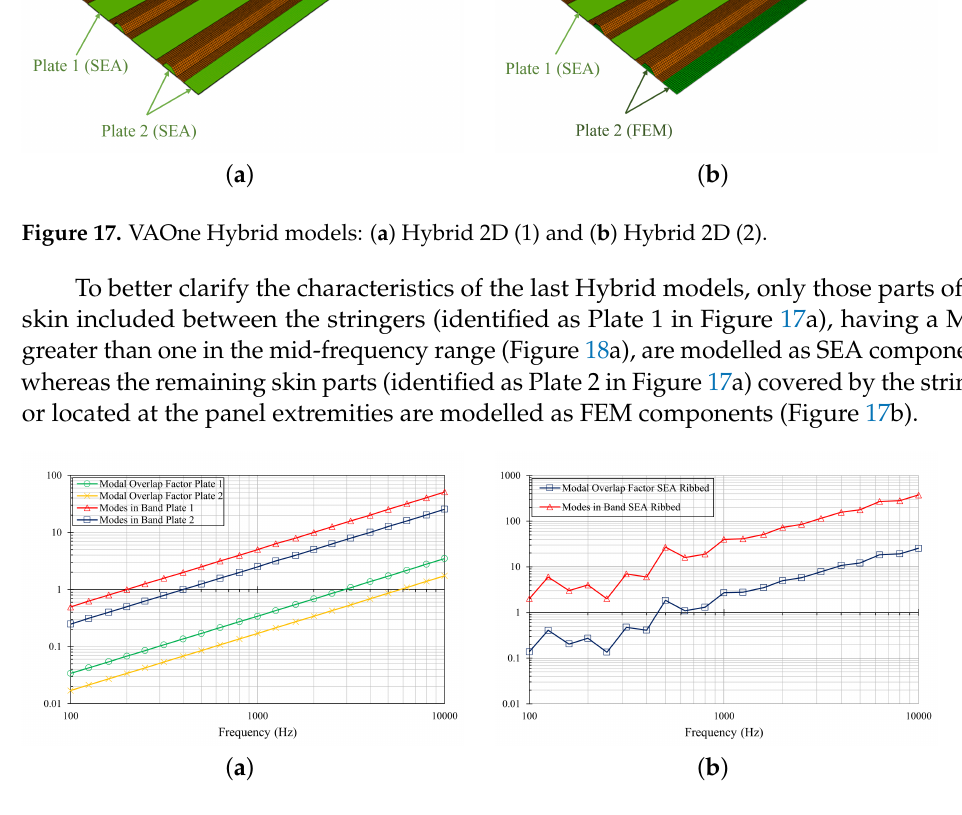
Figure 18. Modal overlap factor and modes in band: ( a ) Hybrid model and ( b ) SEA Ribbed